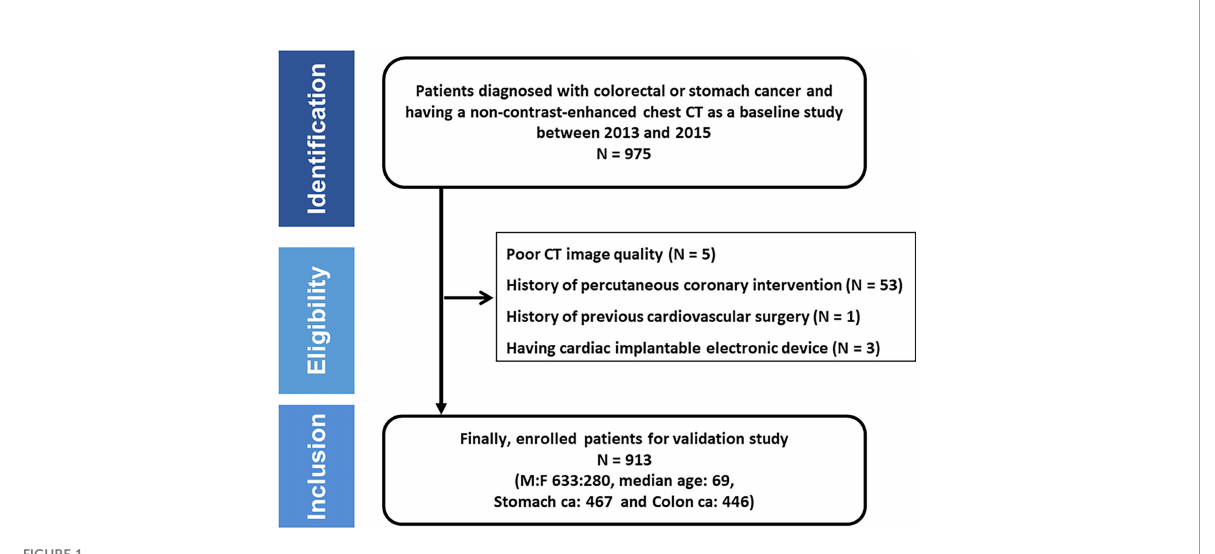
FIGURE 1 Flow chart of patient